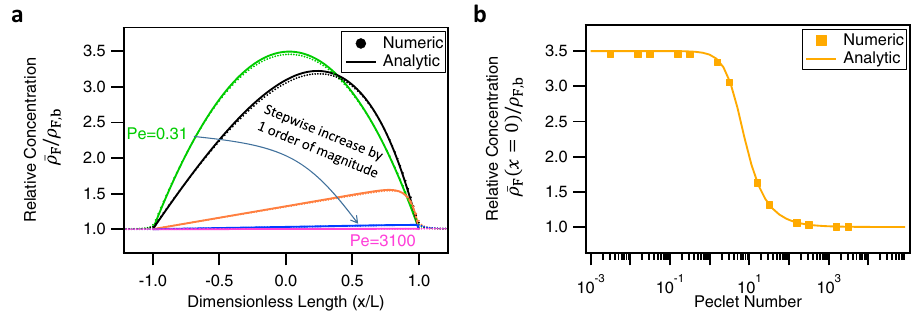
Fig. 7 Numerical and analytic results in the long-channel limit. a Numerical (dashed) and analytic (solid) results for the radially averaged fl uoride concentration pro fi le in the channel as a function of the distance from the center for Peclet numbers ranging from Pe ¼ 0 : 31 (average fl ow velocity 3 : 2 ´ 10 (cid:2) 8 m·s − 1 , green) to 3100 (average fl ow velocity 3 : 2 ´ 10 (cid:2) 4 m·s − 1 , pink) in steps of a factor 10. b Radially averaged concentration at the center of the channel as a function of the Peclet number, comparing analytic (solid lines) and numerical (symbols) results for geologically realistic values ( k d is ¼ 10 (cid:2) 11 mol·m − 2 ·s − 1 , L ¼ 10 (cid:2) 2 m, 10< average fl ow velocity <10 − 4 m·s − 1 ; D = 10 − 9 m 2 ·s − 1 , η = 10 − 3 Pa·s). Note that the considered geometry has length L ¼ 1cm and radius R ¼ 0 : 1mm ensuring that the radius is much smaller than the boundary layer thickness, which is not the case for the experimental